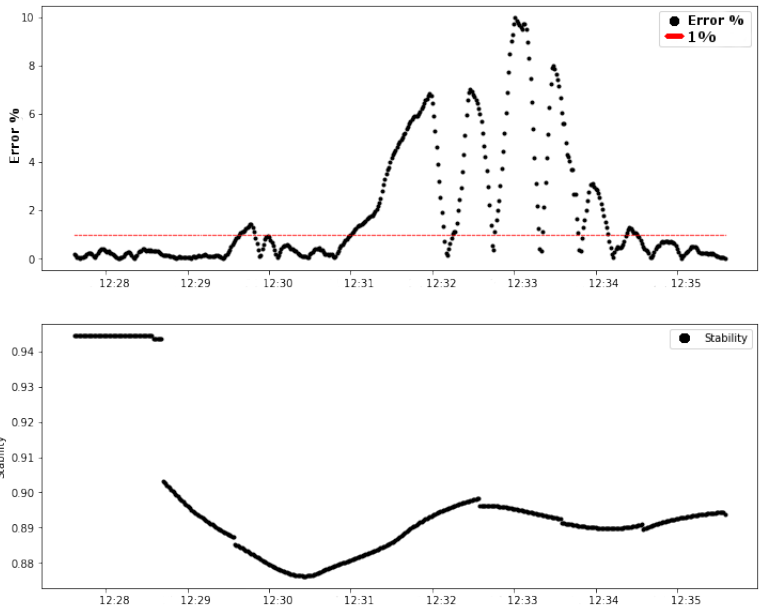
Figure 11. Test 02: error (%) and Link0 stability.